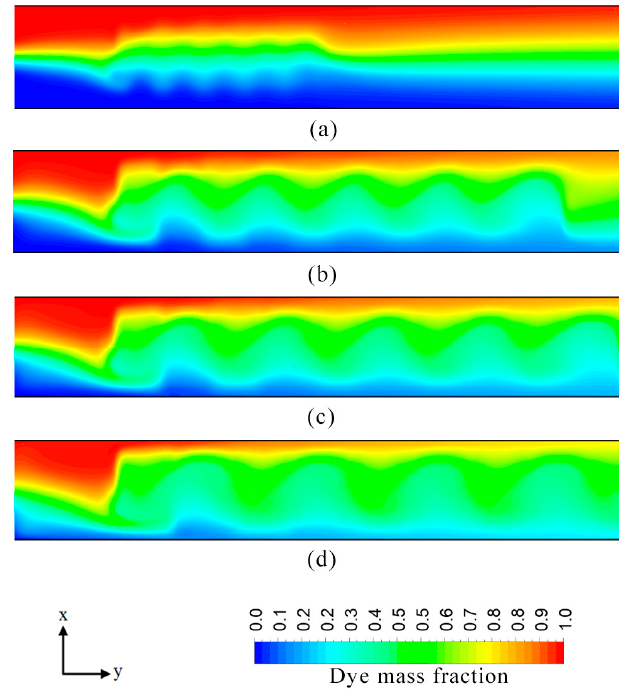
Figure 12. Dye mass fraction distributions on x - y plane along the channel length at z / H c = 0.5 for E = 400 V/cm: ( a ) P L / W c = 0.2; ( b ) P L / W c = 0.43; ( c ) P L / W c = 0.5; and ( d ) P L / W c = 0.6.